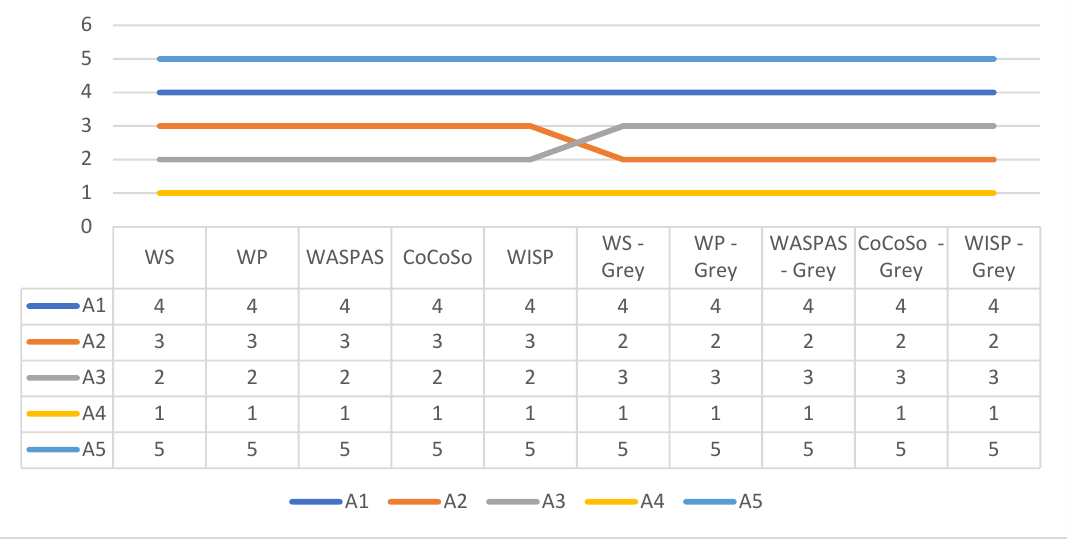
Figure 2. Ranking orders of alternatives obtained on the basis of 100 virtual respondents.